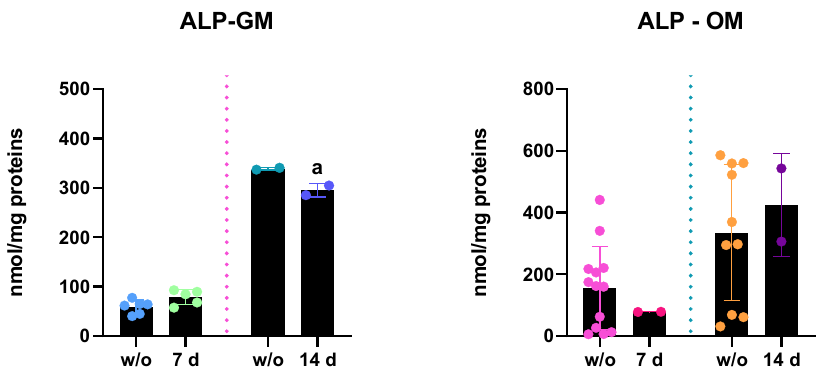
Figure 4. The results shown refer to treated and untreated (+PEMFs and w/o) hASCs kept in GM and OM. The plots show the results of ALP activity, where “a” indicates a statistical significance between w/o and PEMF+ cells, at either 7 or 14 days; in the panel on the right are reported the representative images of ALP activity at 7 days. All the data reported are expressed as the mean ± S.E.M. of six independent experiments. Before the statistical analysis was performed, the raw data were tested for normality with Kolmogorov–Smirnov normality test and further analyzed with unpaired t -test on GraphPad Prism 8.4.2. The results were evaluated as statistically significant (a) when the p -value <